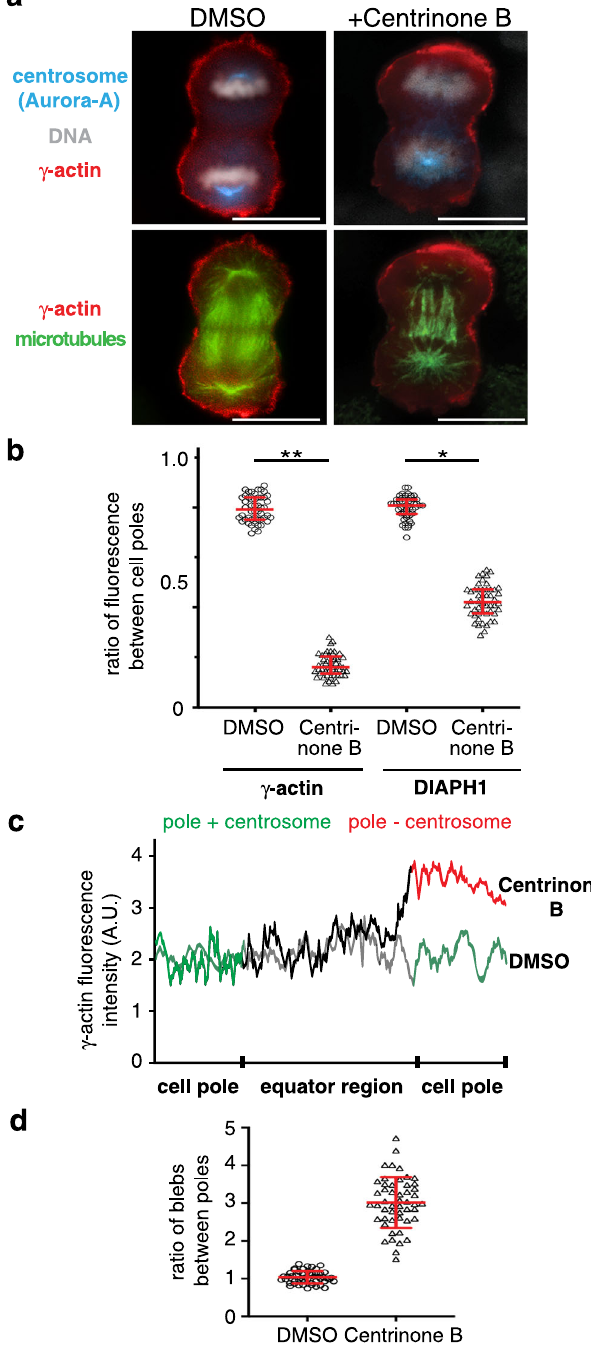
Fig. 4 Astral microtubules are required for polar γ -actin clearance